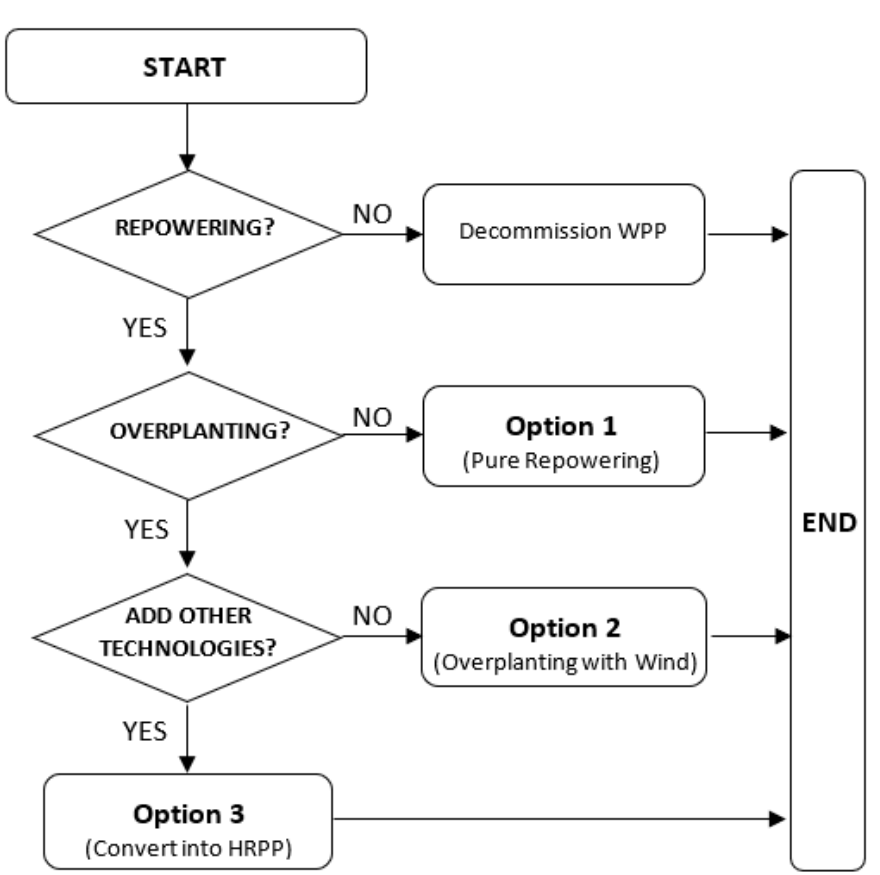
Figure 1. Decision process considered for a wind power plant (WPP) at the end of its lifetime.